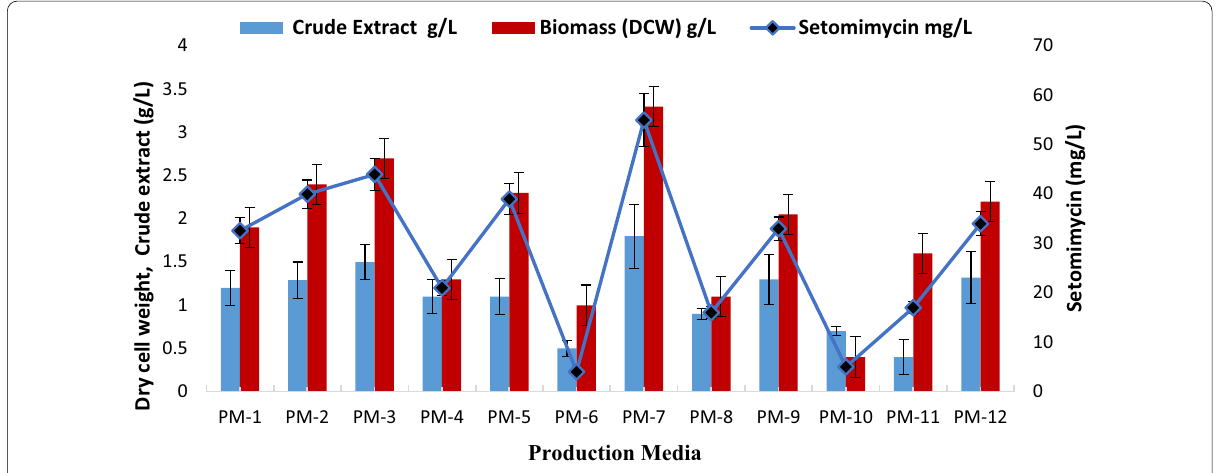
Fig. 1 Effect of production media on fermentation of Streptomyces sp.